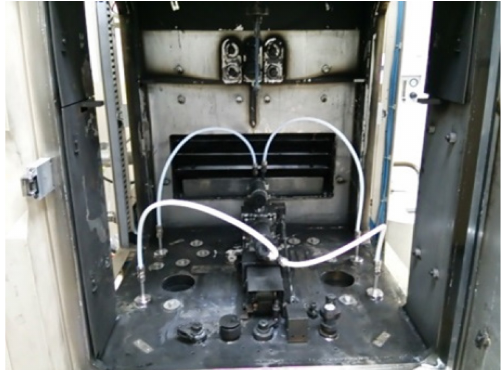
Fig. 3. Photograph of restored deposition apparatus for HBC foil based on EBX-1000 system.